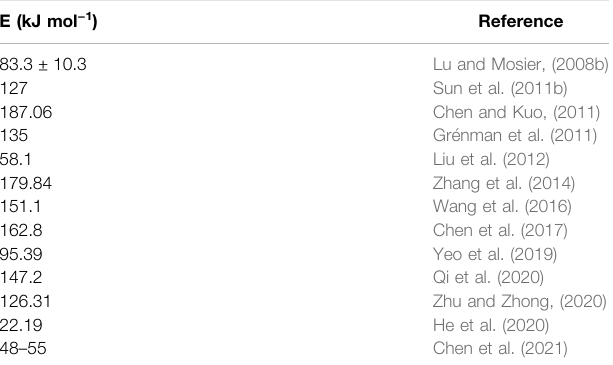
TABLE 3 | The activation energy (E/kJ mol − 1 ) in comparison with hemicellulose hydrolysis. E (kJ mol − 1